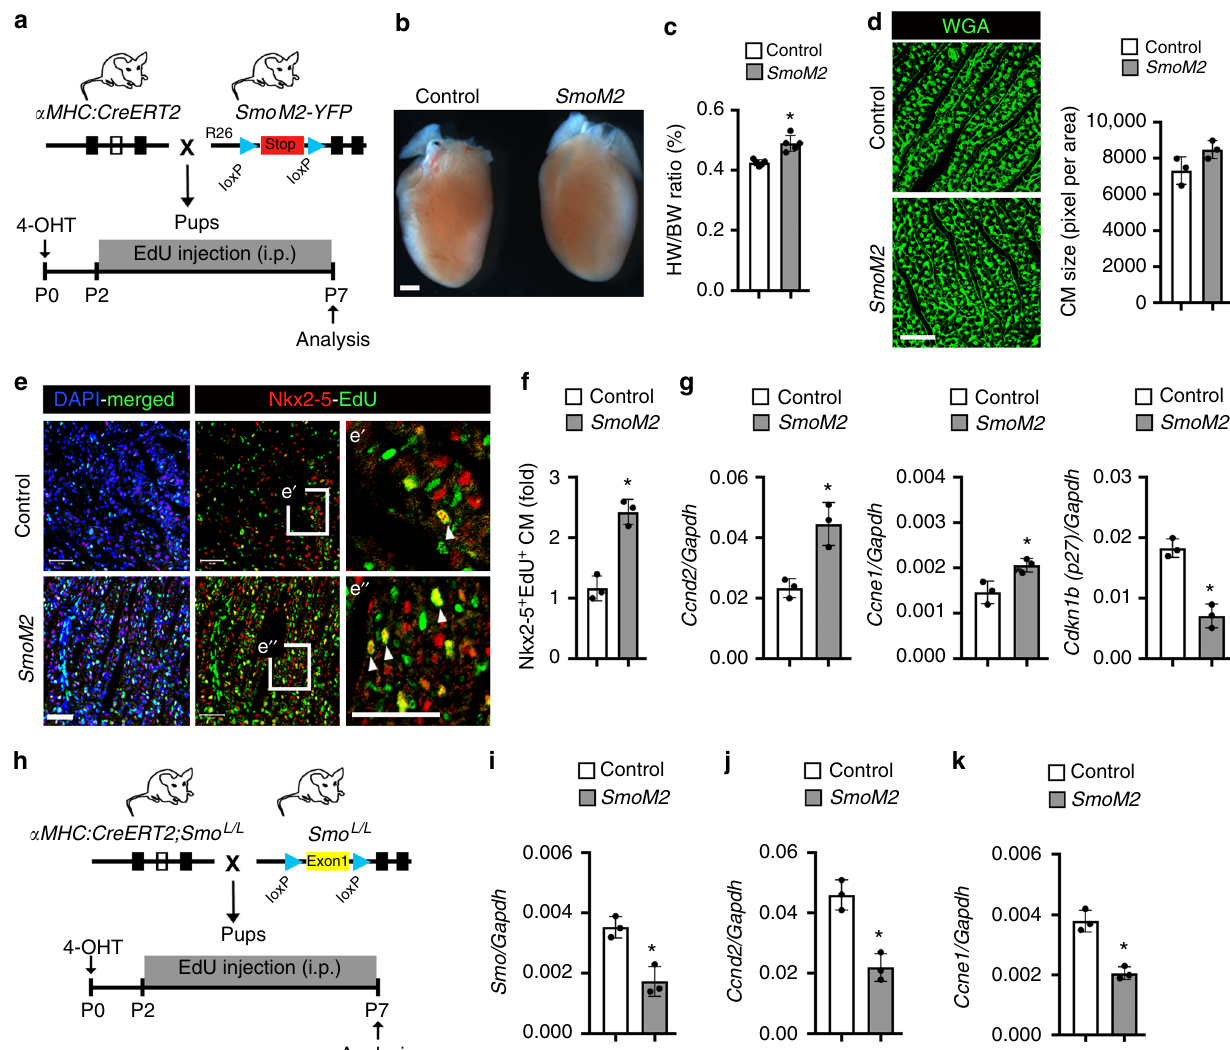
Fig. 3 In vivo activation of HH signaling promotes cardiomyocyte proliferation. a Schematic for the activation of HH signaling and EdU labeling in the postnatal heart during the regenerative window (P2-P7) in the mouse. b Whole-mount images of representative control and SmoM2 hearts obtained by crossing α MHC:CreERT2 with Rosa26-SmoM2/YFP mice. Control mice were not injected with 4-hydroxytamoxifen. c Heart weight to body weight (HW/ BW) ratio in control and SmoM2 mice ( n = 5 per group). d WGA staining and quanti fi cation of the heart sections from control and SmoM2 mice at P7 ( n